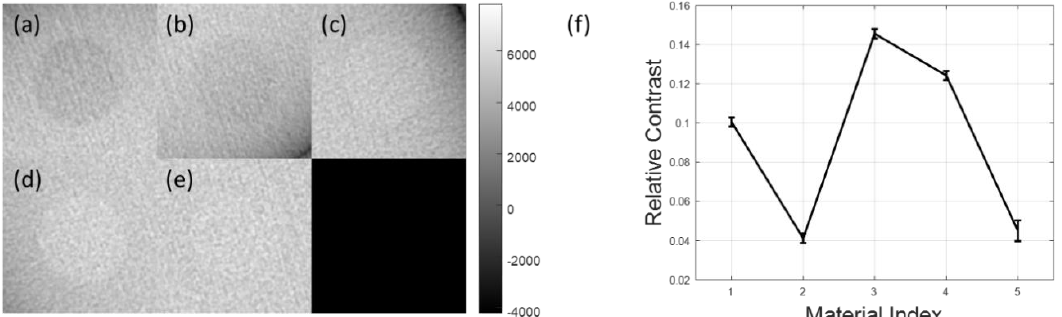
Figure 6. Reconstructed image with configuration (1, 1) using the Hanning window. ( a – e ) The cropped region of interest (ROI) around the center of each material, and ( f ) relative contrast between the target and background with standard deviation error bar as a function of each material.